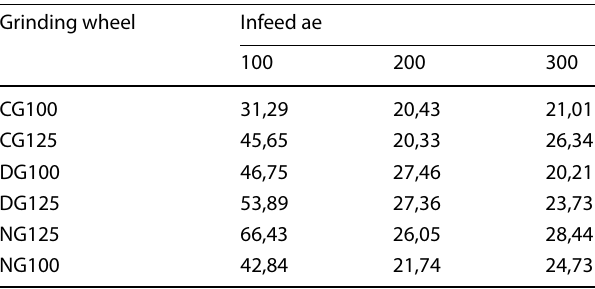
Table 2 Average grain protrusions of the grinding wheels after sharpening